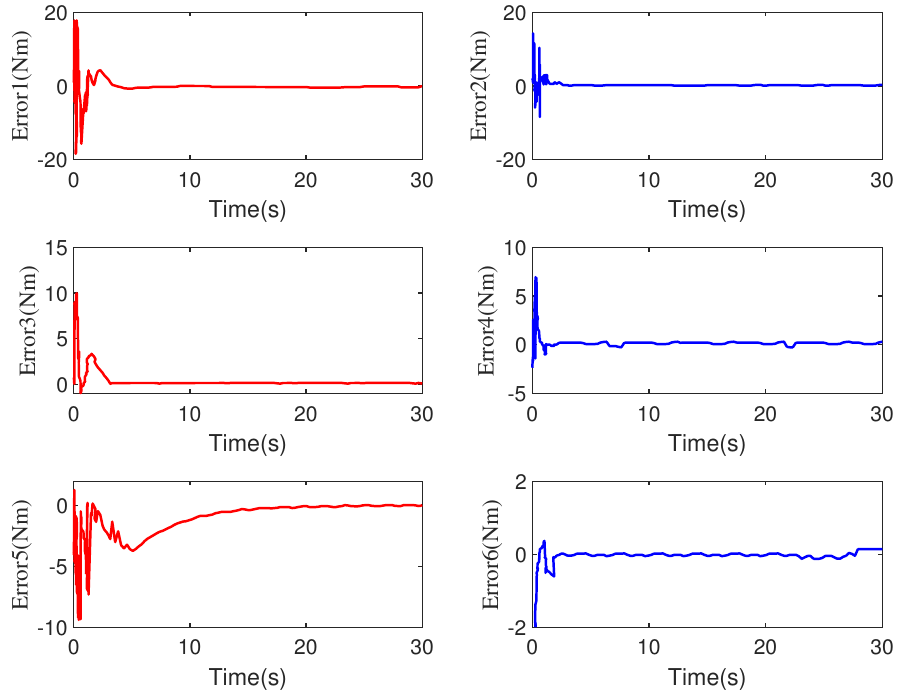
Figure 18. Uncertainties estimation errors with time-varying external disturbances in Case 3 for the 6-DOF robot